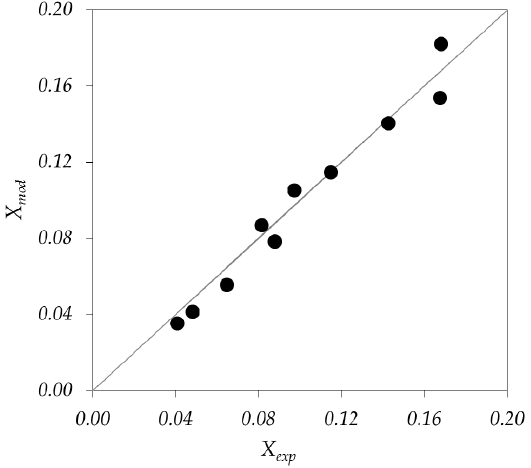
Figure 3. Results of the kinetic parameters estimation. Predicted pollutant conversion vs. experimental conversion (dots). The straight line represents a perfect fit. X mod : Pollutant conversion predicted by the model; X exp : experimental pollutant conversion